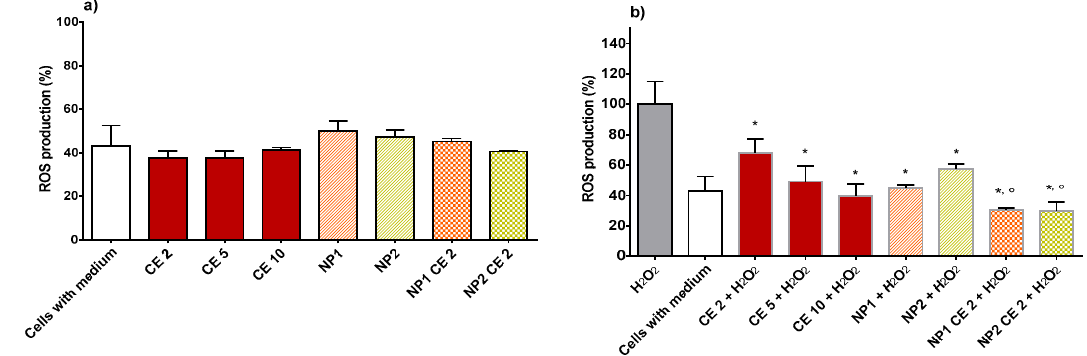
Figure 6. ( a ) shows reactive oxygen species (ROS) production in HUVECs treated with free CE (2, 5, 10 µ g/mL GAE), empty NP1 or NP2, or CE-loaded NP1 or NP2 (CE concentration 2 µ g/mL GAE) for 2 h. ( b ) represents ROS production after 2 h of pre-treatment with free CE (2, 5, 10 µ g/mL GAE), empty NP1 or NP2, or CE-loaded NP1 or NP2 (CE concentration 2 µ g/mL GAE) and subsequent treatment with 50 µ M H 2 O 2 for 1 h. Data are expressed as % ROS production compared to 100% (cell treated with H 2 O 2 ). * Significantly different from H 2 O 2 ; ◦ significantly different from CE 2 + H 2 O 2 .